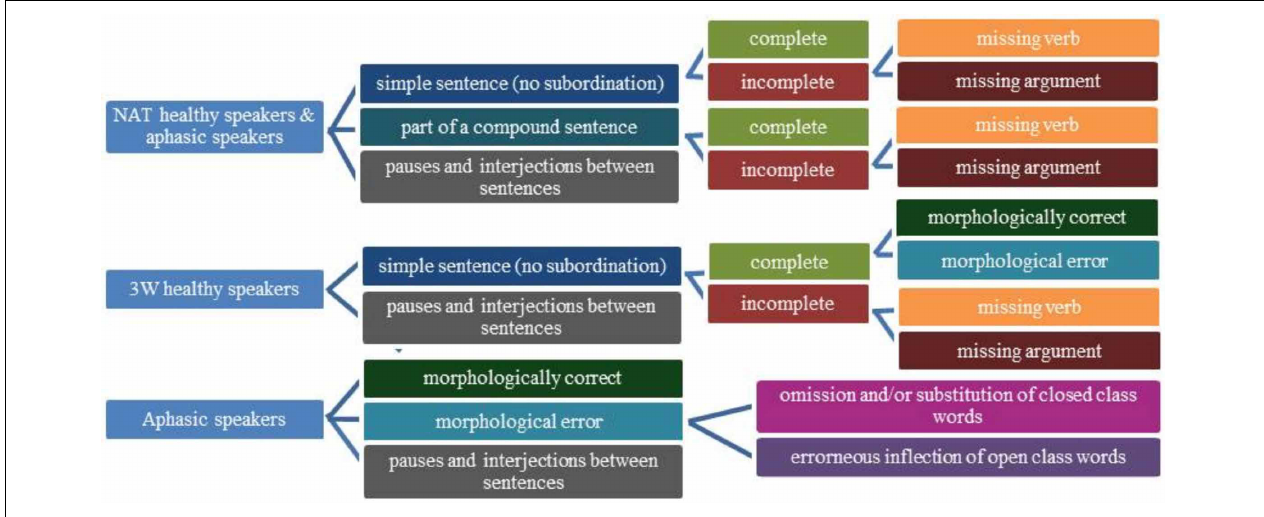
FIGURE 3 | Categories for classification of clause-like